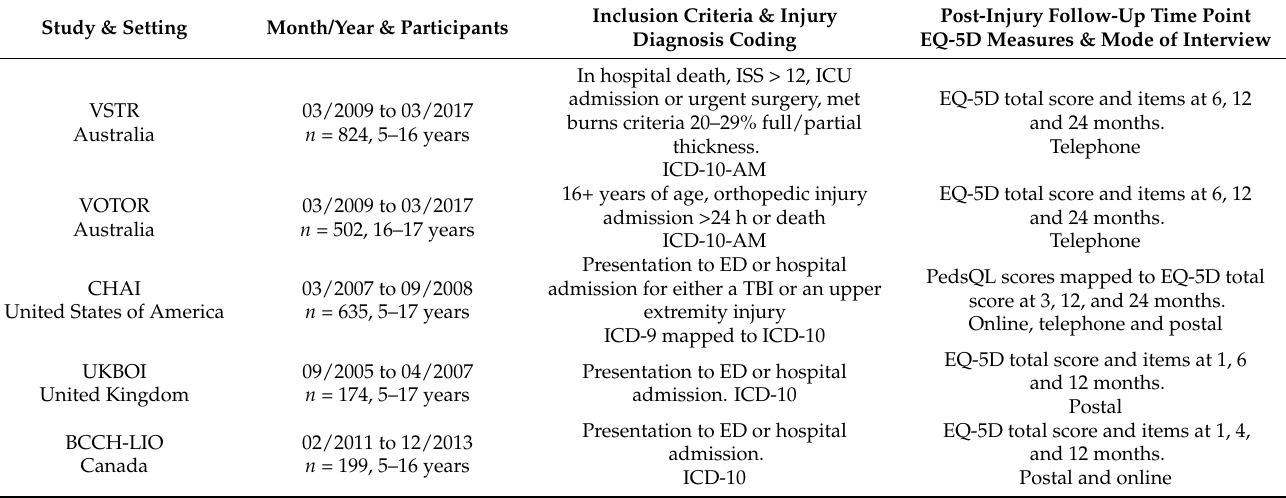
Table 1. Specific details of VIBES-Junior